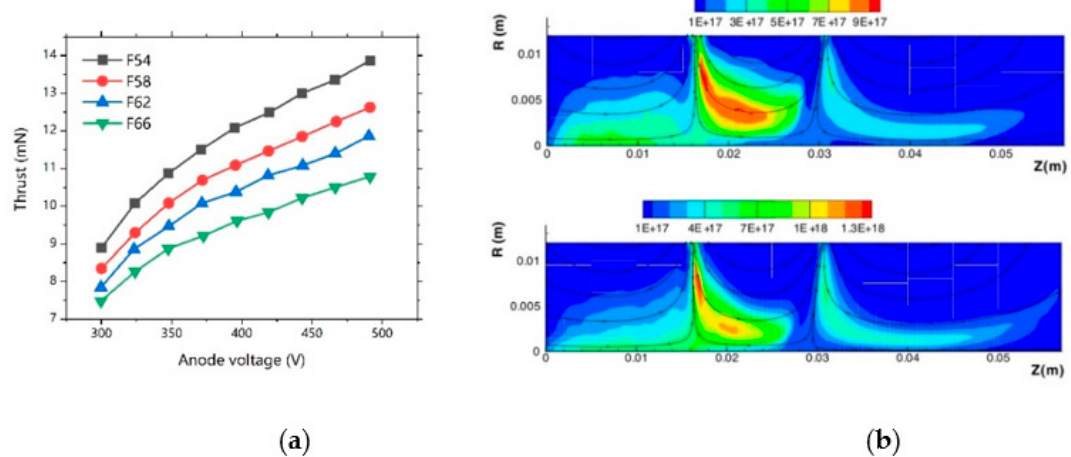
Figure 9. ( a ) Experimental results and ( b ) simulated electron density distribution of magnetic field strength effect in a cusped field thruster. In ( a ) F54–66 is the outer diameter (mm) of the magnets. In ( b ) the electron density distribution is plotted in /m 3 .